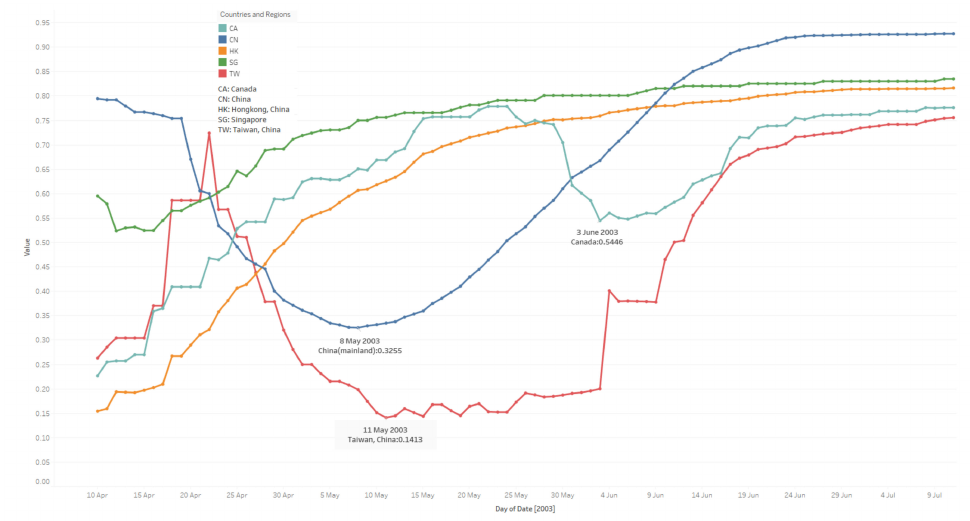
Figure 3. To-date cured rate trends of five countries and regions. (10 April–11